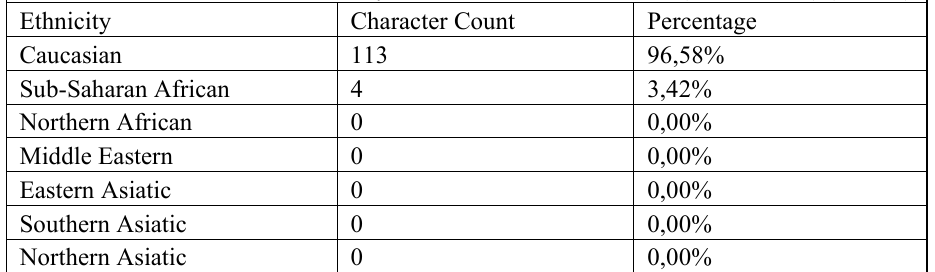
Table 10. LGBT+ character ethnicity in Flemish television fiction (2001 – 2016) (N=117) Ethnicity